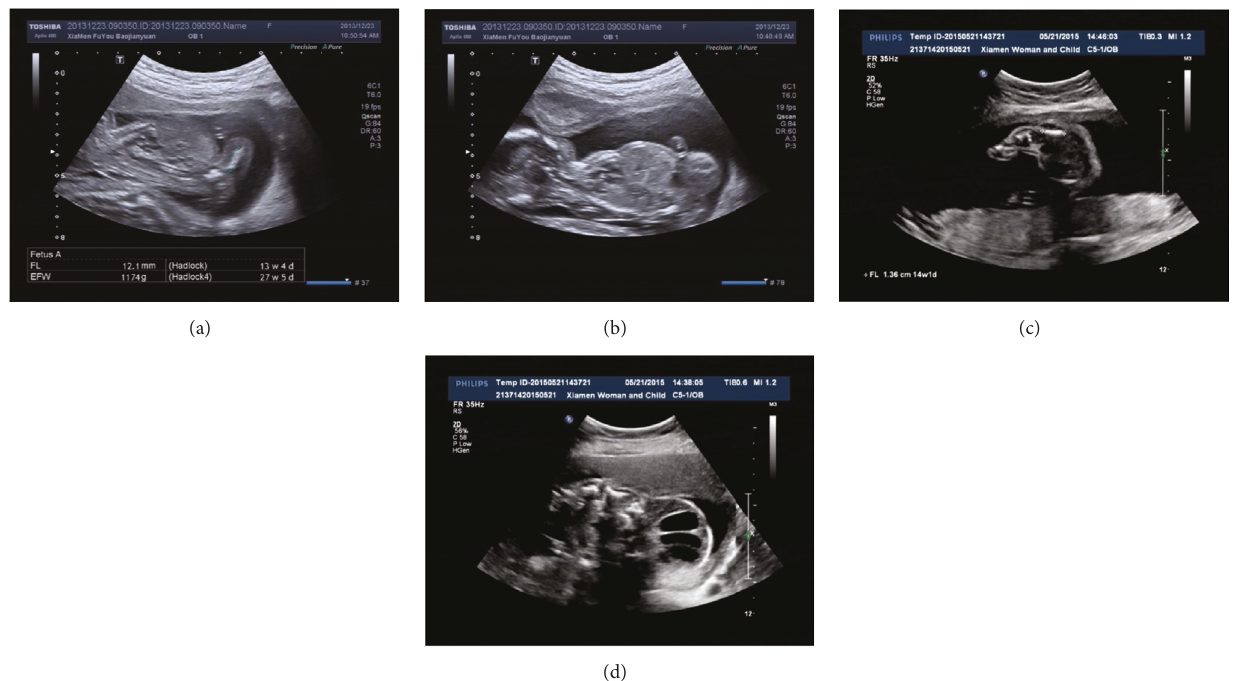
Figure 1: (a)Case1: sonogram of femur length, whichis extremely short.(b) Case1: ultrasoundscans showing narrow thoraxand protuberant abdomen. (c) Case 2: sonogram of femur length, which is extremely short. (d) Case 2: ultrasound scans showing a large cystic